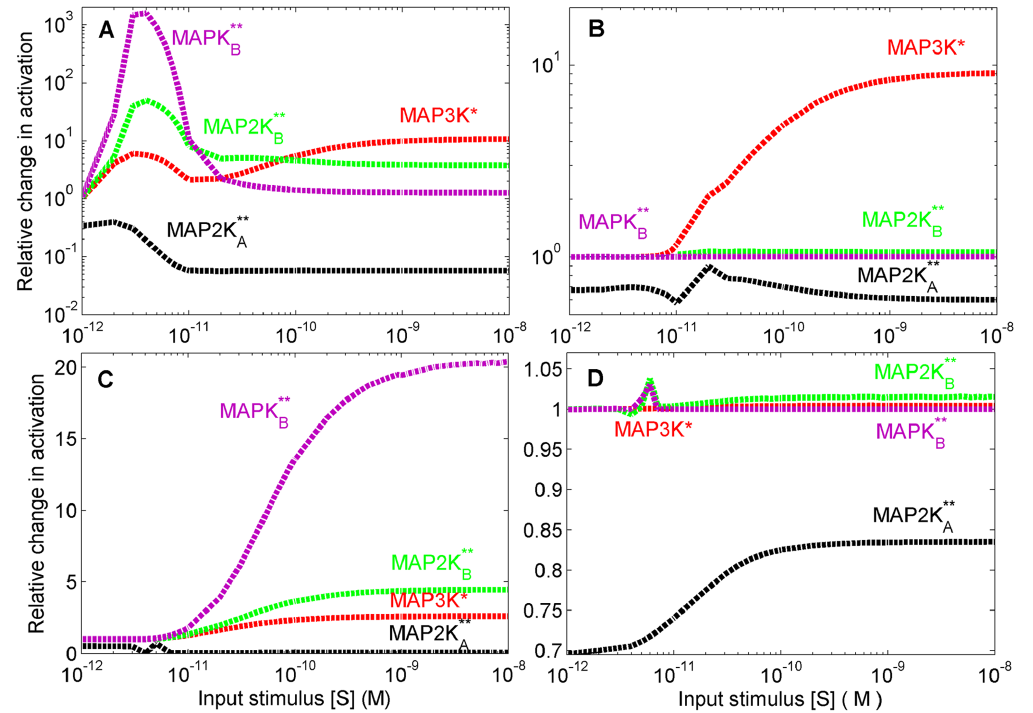
Figure 6. Role of branch asymmetry. Relative increase in response as a function of signal concentration on blocking MAPK A activation when the , k A and k A ) or (B) branch B ( k B , k B and k B ) are 10 times higher than those in the other branch, and, when binding reaction rates for (A) branch A ( k A 5 7 5 7 3 3 the total concentrations of MAPK and MAP2K in (C) branch A or (D) branch B are 10 times higher than the corresponding values for the other branch (=mean value in the Huang-Ferrell range). Note that in (A) the MAPK B activation can increase by more than 1000 times for a particular range of signal strength. In contrast, there is relatively little change in the activity of the two branches when the activation of the terminal kinase for the branch having lower values of reaction rates is